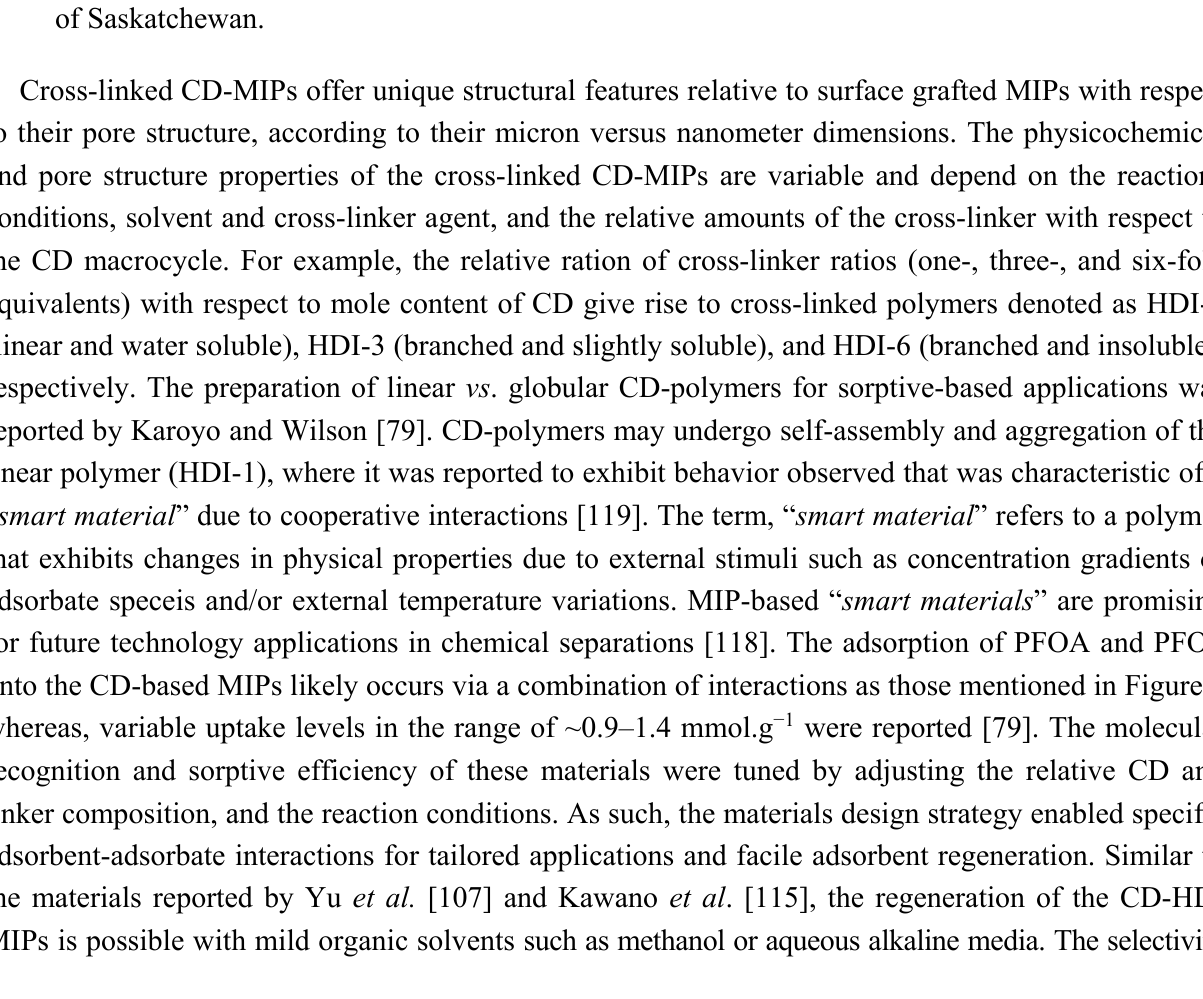
Figure 8. Association of a CD (cone) and a bi-functional reagent (e.g., diisocyanate cross-linker; wavy lines) to form linear (top) or branched (bottom) urethane based polymer materials, where guest (spheres) can bind in the inclusion sites or within the interstitial regions. Reproduced with permission from [118], Copyright 2014, University of